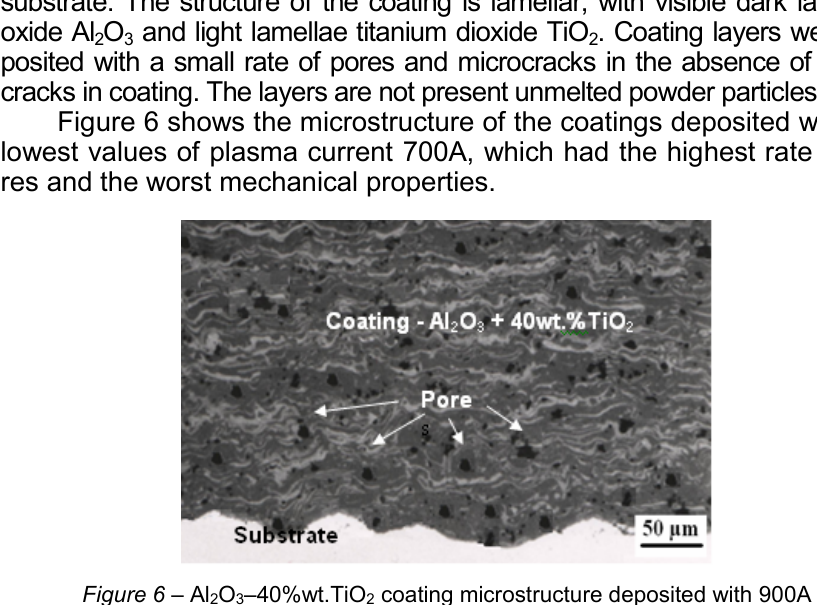
Figure 6 – Al 2 O 3 –40%wt.TiO 2 coating microstructure deposited with 900A Slika 6 – Mikrostruktura Al 2 O 3 –40%tež.TiO 2 slojeva prevlake deponovane sa